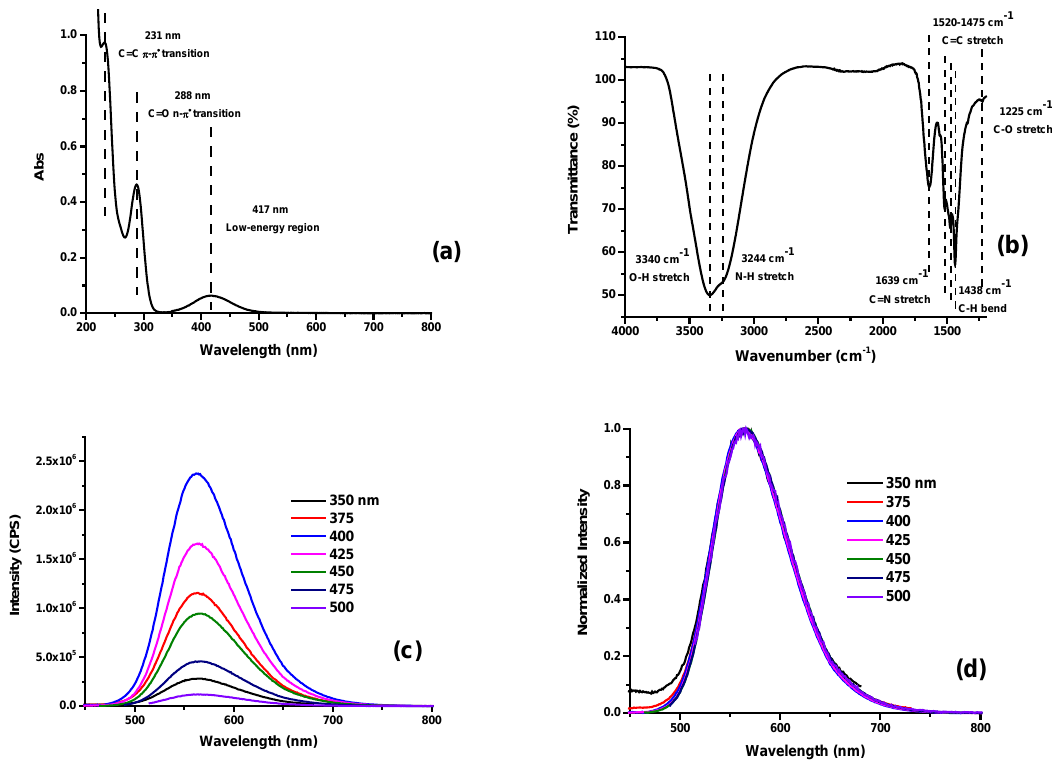
Figure 1. ( a ) The UV/vis absorption and ( b ) The attenuated total reflection-Fourier-transform infrared (ATR-FTIR) spectrum of orange carbon dots (O-CDs) powder; ( c , d ) fluorescence spectrum and the normalized fluorescence spectrum of O-CDs aqueous solution. The concentration of O-CDs for UV/vis and fluorescence measurement is 0.03 and 0.005 mg/mL, respectively.